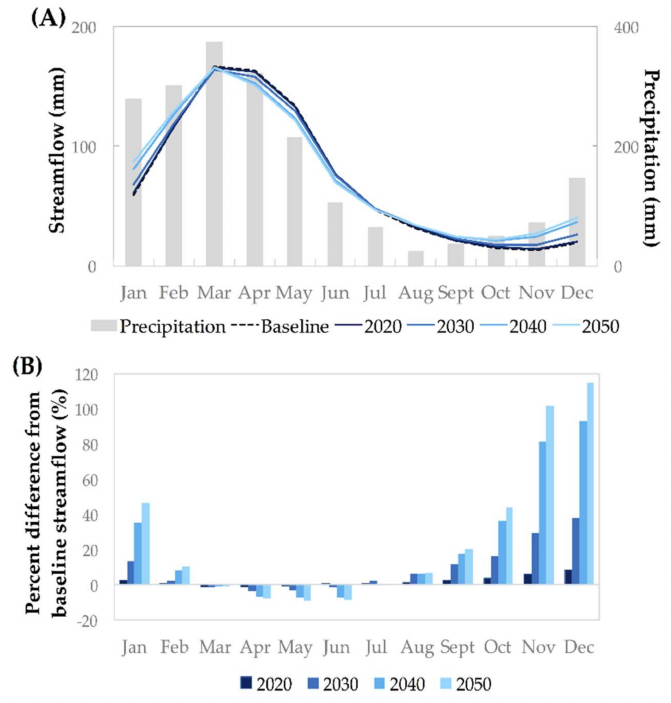
Figure 6. ( A ) Monthly average simulated streamflow and ( B ) percent differences between monthly